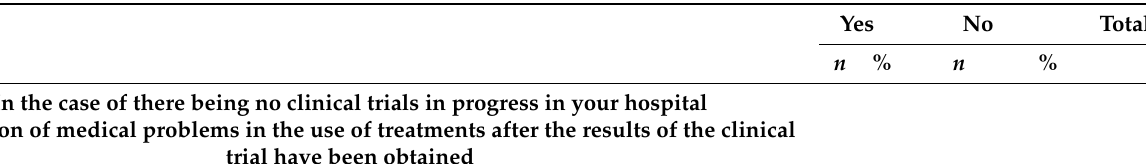
Table 1. Quantitative analysis of the perception of the usefulness of clinical trials Galicia, 2020.